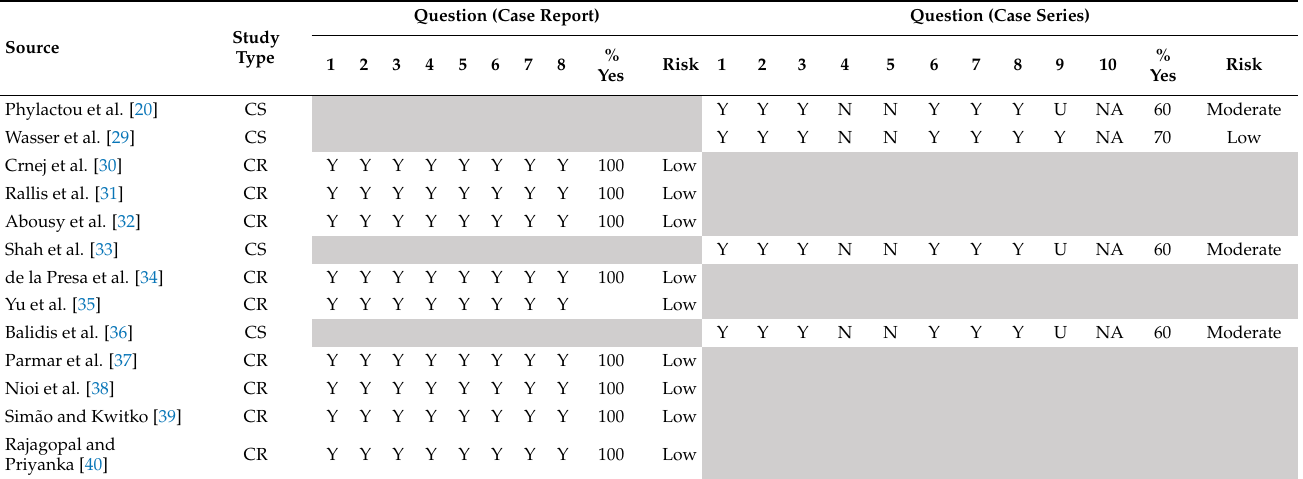
Figure 1. PRISMA flowchart illustrating the article selection process. PRISMA, Preferred Reporting Items for Systematic Reviews and Meta-Analyses. Table 2. Risk of bias assessment for included articles using the Joanna Briggs Institute Critical Appraisal Checklist for Case Reports and Case Series.